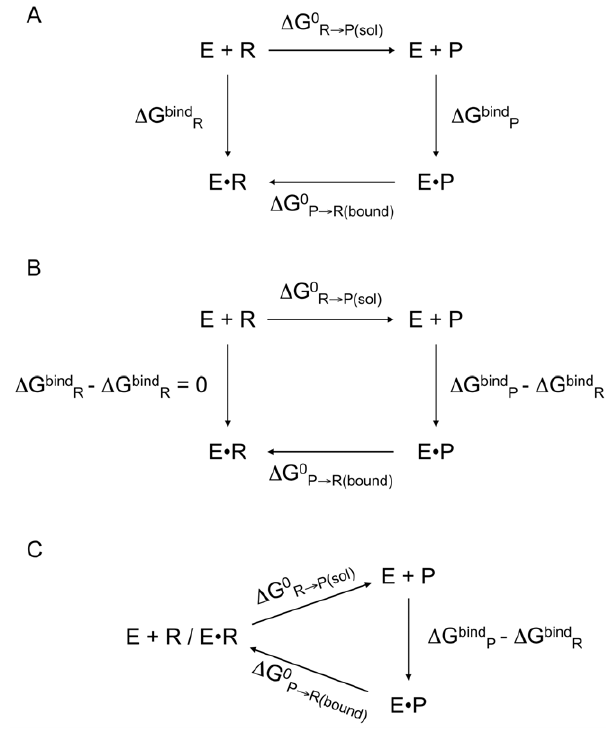
Figure 7. Thermodynamic cycles for the cyclization reactions of hydrolyzed biapenem. A. Thermodynamic cycle relating the energy of the cyclization reaction in solution with the energy of the same reaction in the enzyme active site. E N R and E N P are the enzyme:reactant and the enzyme:product complexes, respectively. B. Intermediate step leading to the collapsed thermodynamic cycle shown in panel C. C. Collapsed thermodynamic cycle in which the same energy quantity ( D G bind R ) has been subtracted from the vertical legs of the cycle shown in panel A. The difference between the catalyzed (lower branch) and the uncatalyzed reaction (upper branch) reflects the difference in the free energy of binding ( D G bind ) of the product versus the reactant (vertical leg). While this cycle does not represent a real physical entity, it provides a rationalization for the convention adopted in Figure 6 , according to which all the free energy profiles of the reaction in the enzyme were placed with their origin coincident with that of the reaction in solution.